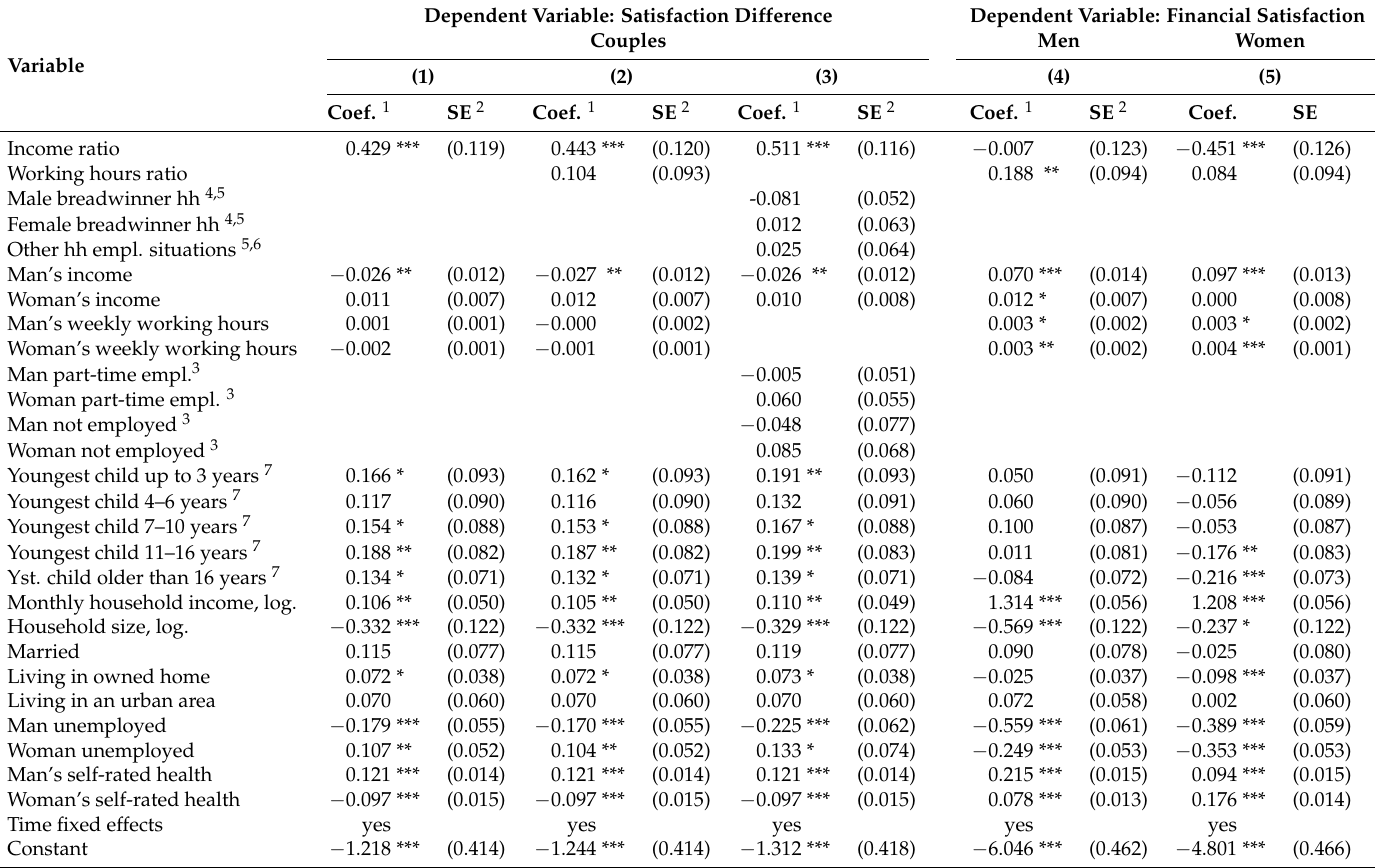
Table 2. Determinants of differences in financial satisfaction and of financial